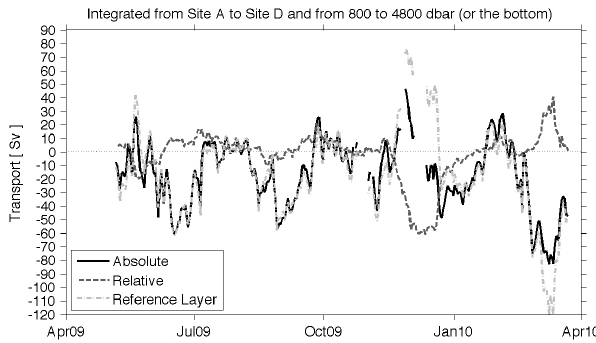
Fig. 8. Absolute transport (black line) integrated between Sites A and D within the nominal DWBC layer (800–4800dbar). Also shown are the components of the absolute transport associated with velocity relative to an assumed level of no motion at 800dbar (dark gray dashed) and with the absolute velocity actually observed at the level of no motion reference layer (light gray dash-dot).